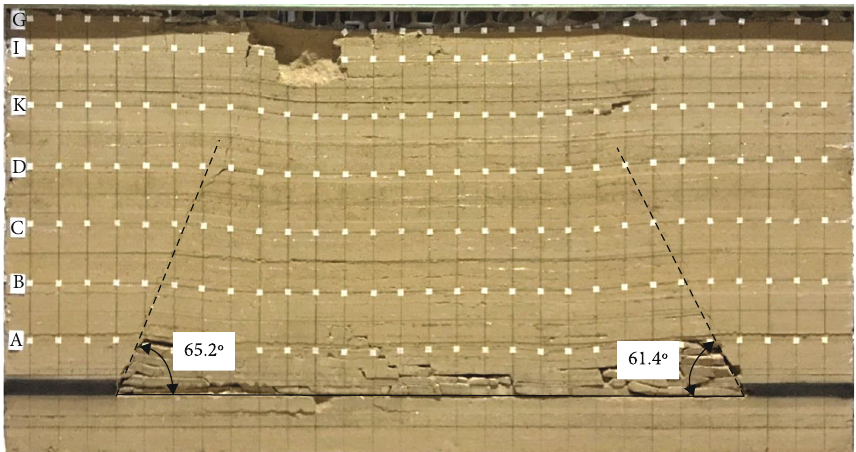
Figure 3: Damage of bedrock obtained by physical simulation.